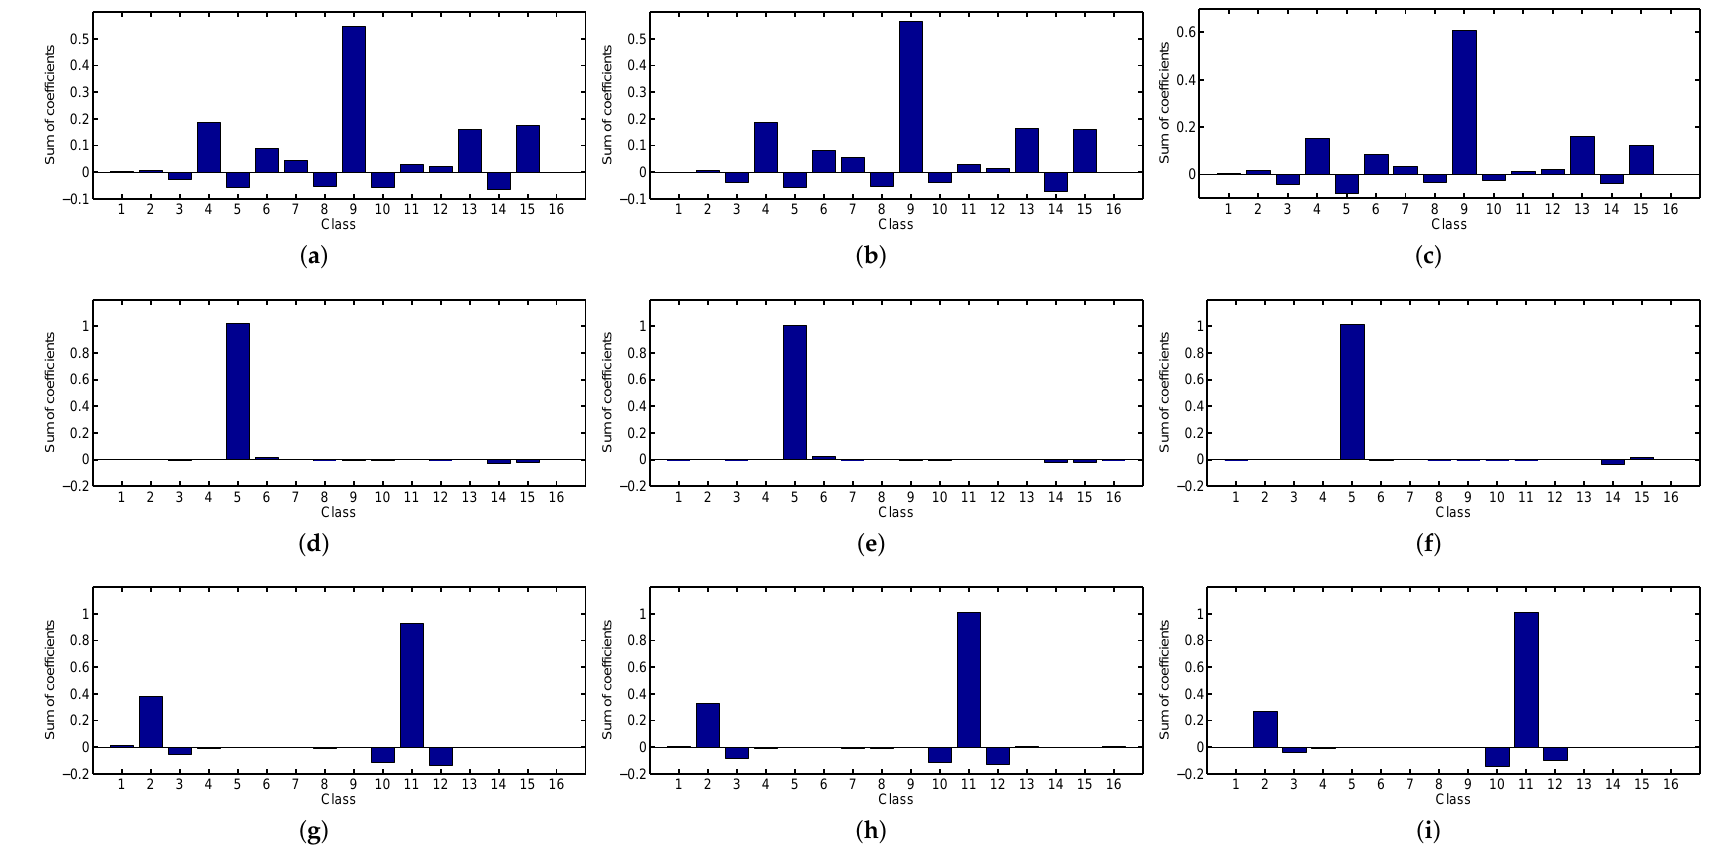
Figure 2. Sum of the estimated coefficients for the pixels in the Airborne Visible/Infrared Imaging Spectrometer (AVIRIS) Indian Pines dataset (about 5% training pixels are used, see Section 4), the corresponding class labels are included in the parentheses. ( a – c ): Pixel taken from Class C9. ( d – f ): Pixel taken from Class C5. ( g – i ): Pixel taken from Class C11. ( a ) KNLS (C9). ( b ) KFCLS (C9). ( c ) KSRC (C9). ( d ) KNLS (C5). ( e ) KFCLS (C5). ( f ) KSRC (C5). ( g ) KNLS (C11). ( h ) KFCLS (C11). ( i ) KSRC